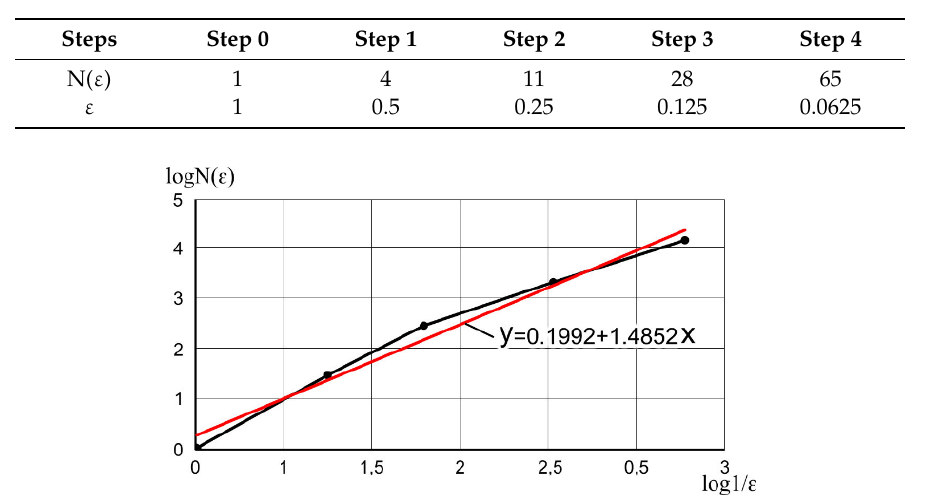
Figure 6. The regression line to estimate the fractal dimension. Table 1. The change of N(  ) versus different values of  for the example in Figure 5.